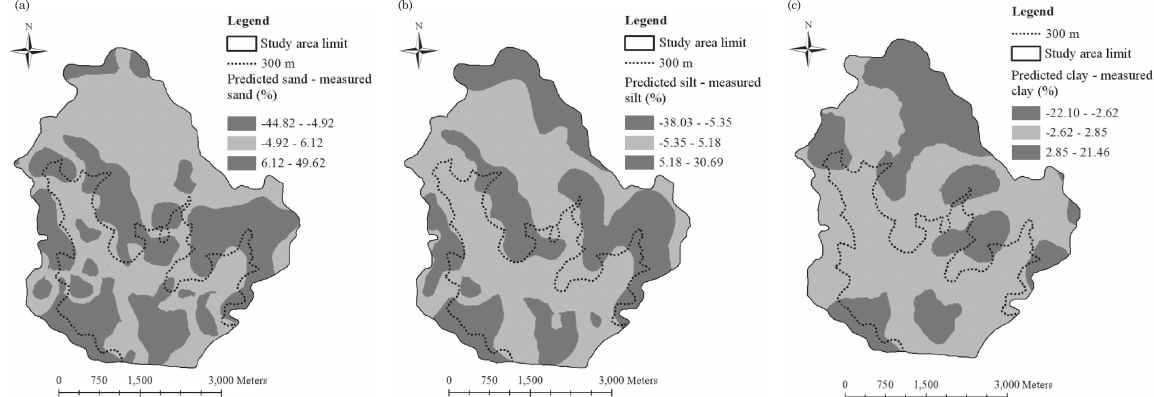
Figure 4. Quantiles of the kriged residuals of the particle-size distribution: (a) sand, (b) silt, and (c) clay, of the soils predicted using the predictive models PMs-1. Table 3. Cross-validation statistics (10-fold; 50 repetitions) for prediction of particle-size distribution based on application of predictive models PMs-2 and PMs-3